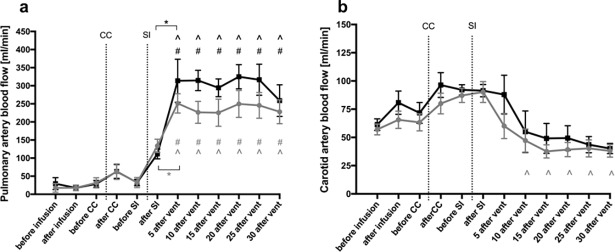
Left pulmonary artery blood flow (a) and carotid artery blood flow (b) in caffeine treated (grey dots) and control (black squares) lambs. The figure shows mean± SEM values at different time points during the experiment: before caffeine/ saline infusion; after caffeine/ saline infusion; before cord clamping (CC); after CC; before sustained inflation (SI); after SI; 5, 10, 15, 20, 25 and 30 minutes after ventilation onset. * indicates significant difference between two adjacent time points (grey within caffeine group, black within saline group). # indicates significant difference compared to “before CC” (grey within caffeine group, black within saline group). ^ indicates significant difference compared to “before SI” (grey within caffeine group, black within saline group).